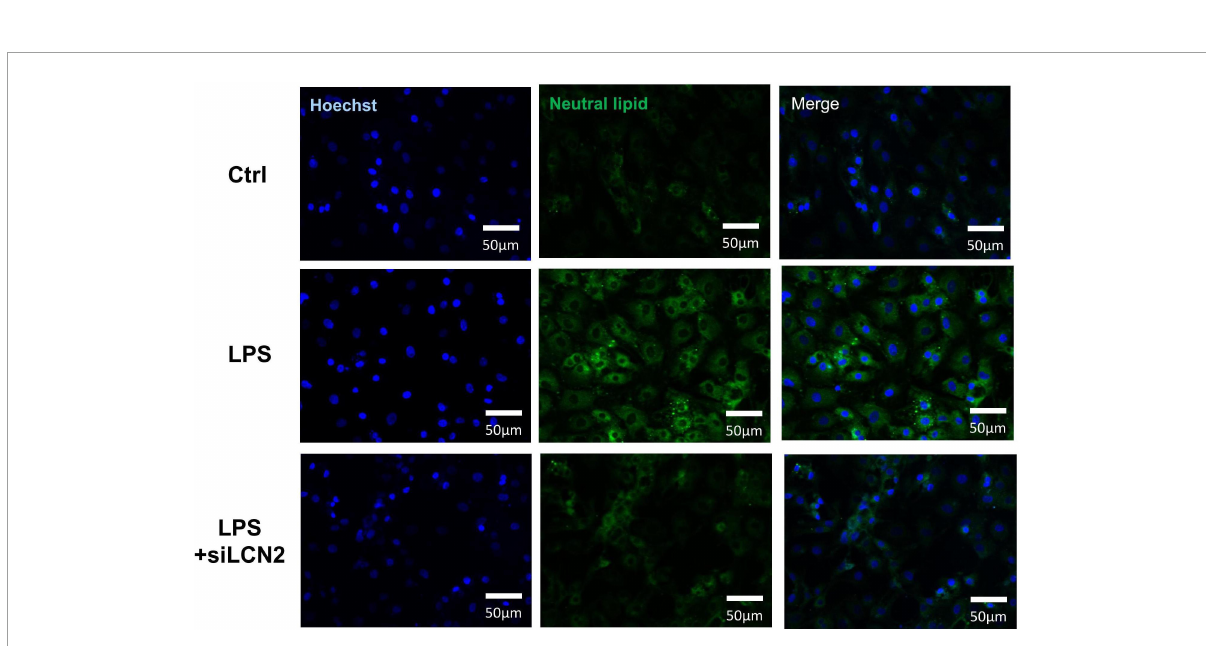
FIGURE7 Neutral lipid staining of LPS damaged H9C2 cardiomyocytes at 12h after LPS stimulation. The inhibition of LCN-2 alleviated the lipid accumulation in H9C2 cells caused by LPS